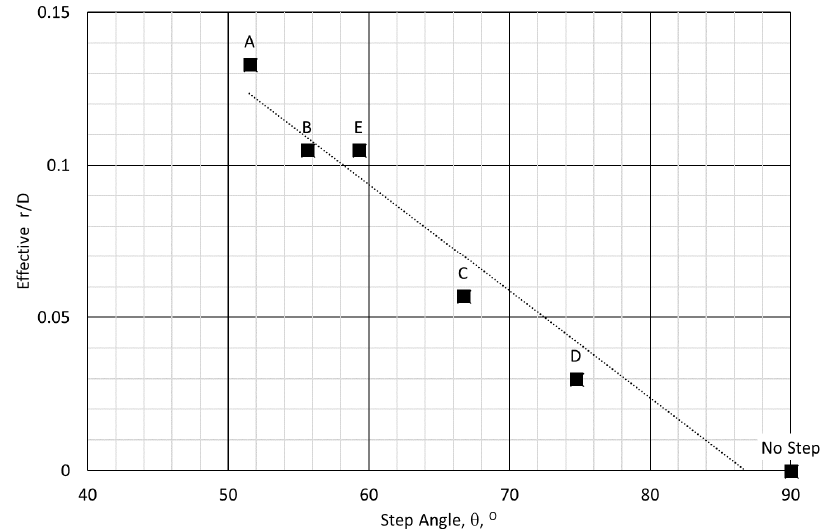
Figure 8. Effective r / D value to produce best fit correlation with varying step angle.